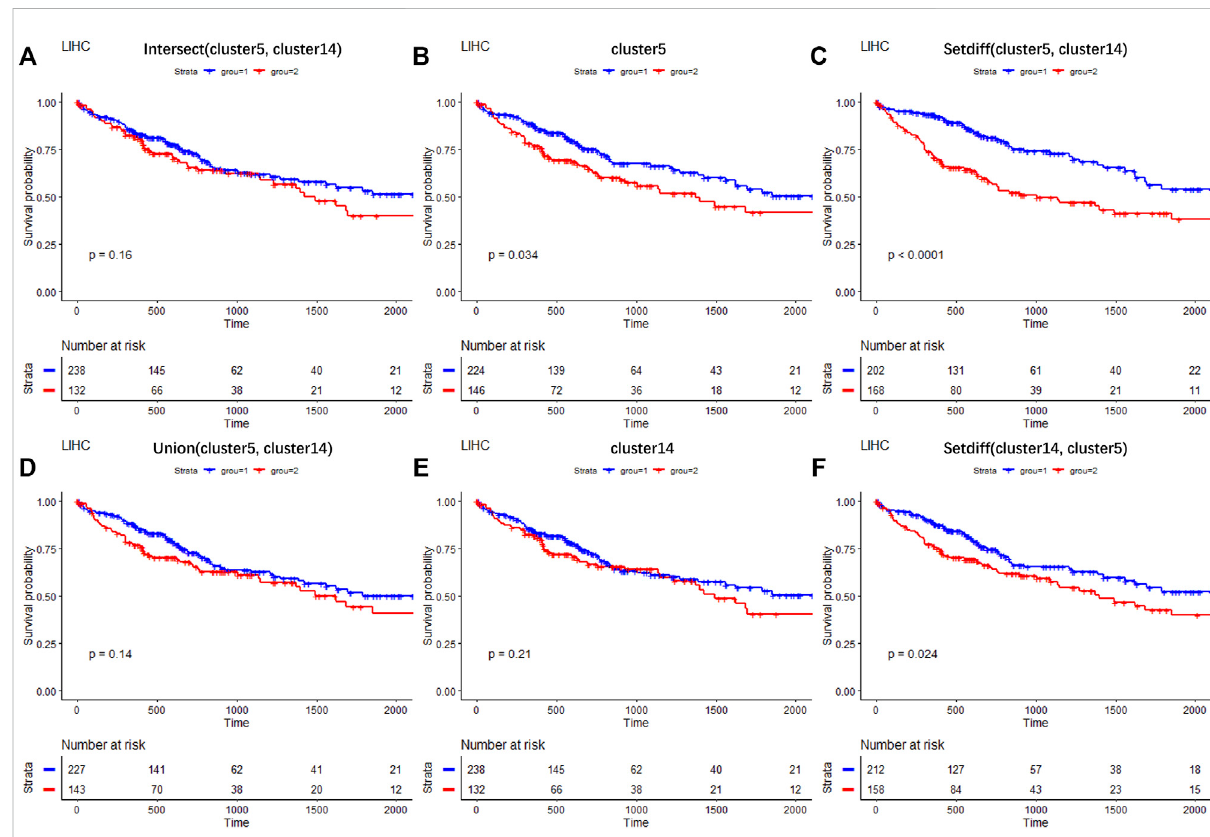
FIGURE 8 Results of survival analysis on selected DEGs across TCGA LIHC clinical data. Survival curves on the intersection of DEGs between cluster 5 and cluster 14 (A) ; on DEGs of cluster 5 (B) ; on DEGs belonging to cluster 5 but not to cluster 14 (C) ; on the combination of DEGs between cluster 5 and cluster 14 (D) ; on DEGs of cluster 14 (E) ; on DEGs belonging to cluster 14 but not to cluster 5 (F)